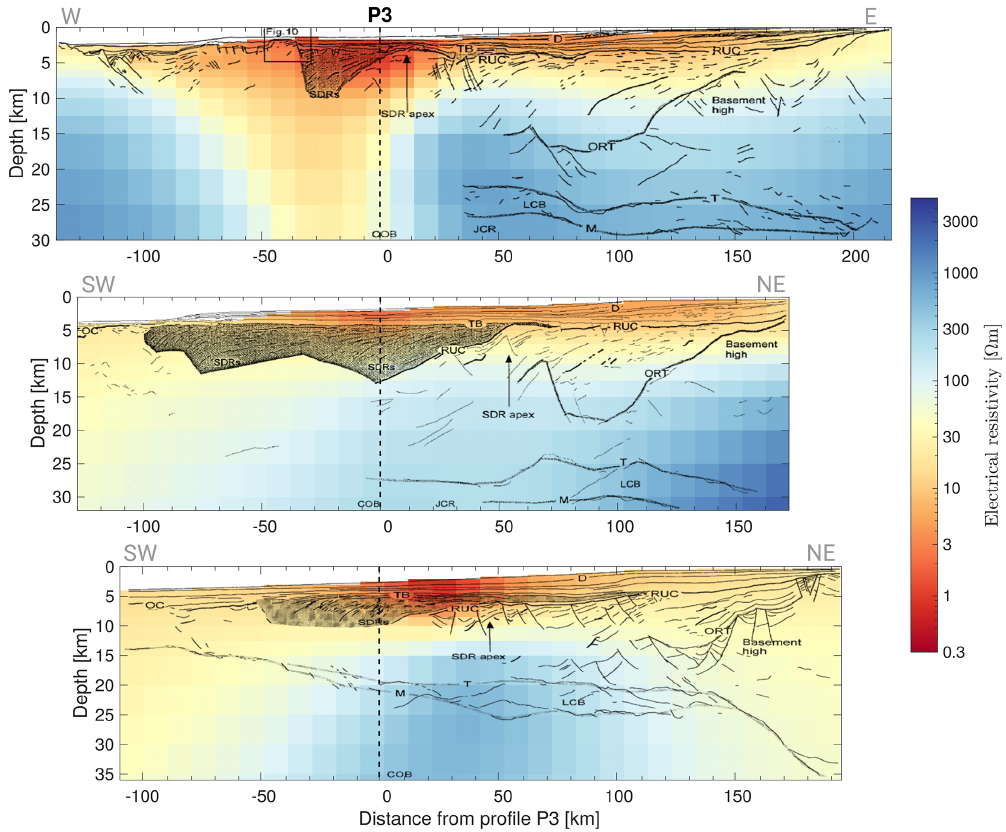
Figure 7. Vertical slices through the 3D resistivity model along seismic transects presented in Gladczenko et al. (1998) overlaid with their lines drawings of MCS (multi-channel seismic) data. From top to bottom are their transects 2, 3, and 4 (their Figs. 4 to 6). Location of transects is shown in Fig. 1. Vertical dashed line is the intersection with our profile